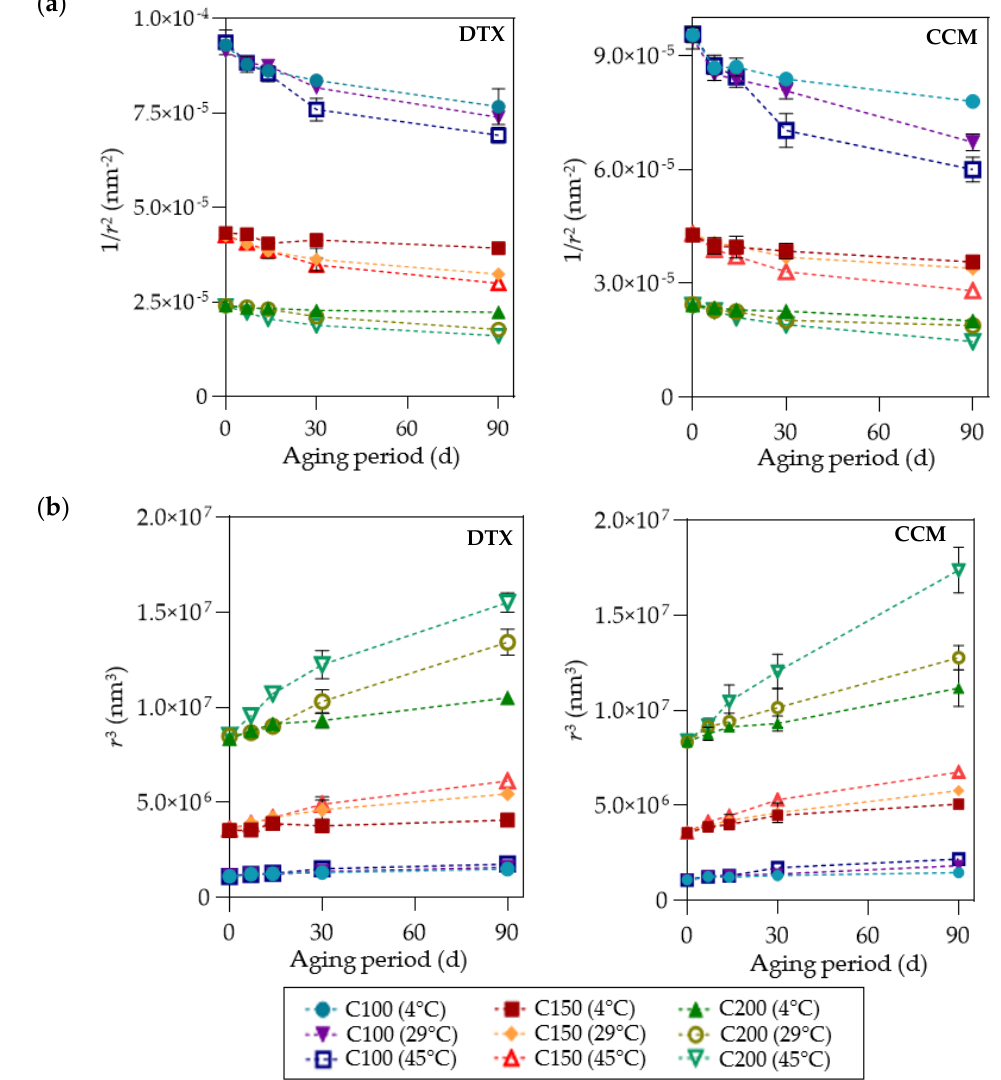
Figure 4. Graph of ( a ) coalescence (1/ r 2 ) and ( b ) Ostwald ripening ( r 3 ) of DTX- and CCM-loaded nanoemulsions against aging time ( t ) at different incubation temperatures. Error bars denote standard deviation ( n = 3). DTX/D: Docetaxel; CCM/C: Curcumin; r : Mean particle size; d: Day.